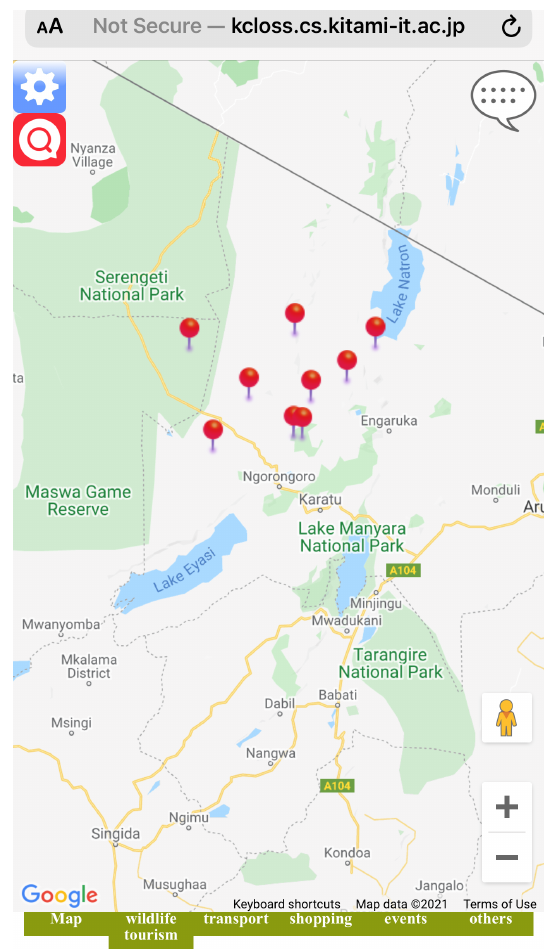
Figure 11. example of registered sightspots in the